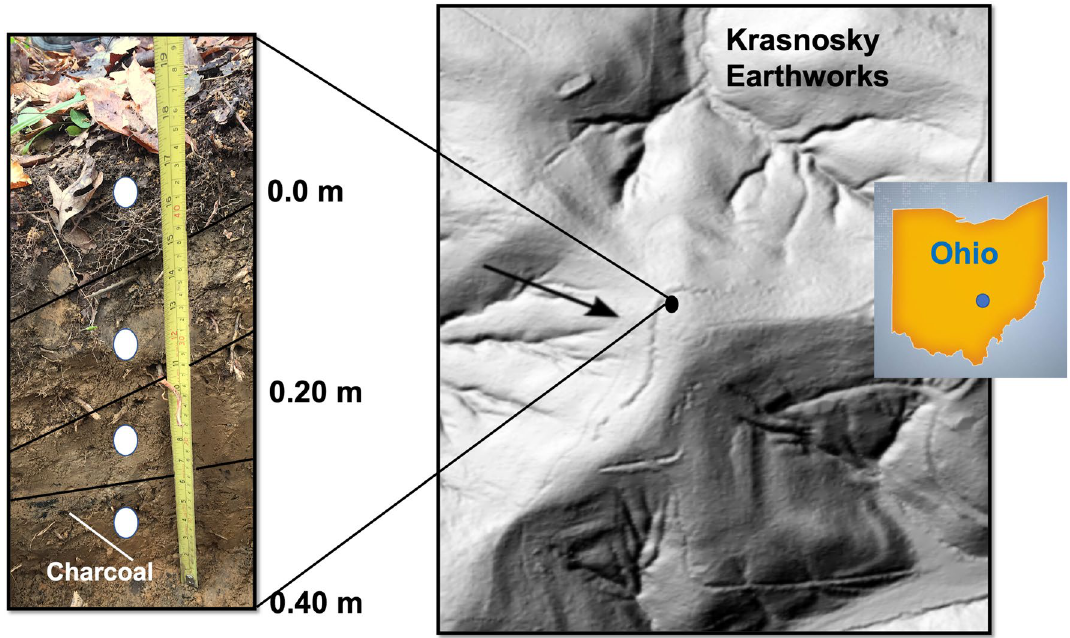
Figure 10. The location, stratigraphy, and sediment sample sites (white circles) of the Krasnosky earthworks, Hocking County, Ohio. Kenneth Barnett Tankersley used Microsoft PowerPoint for Mac Version 16.41 (www. micro soft. com) to create this figure. The GIS map was produced in ESRI ArcGIS 10.3.1 software (www. esri. com).